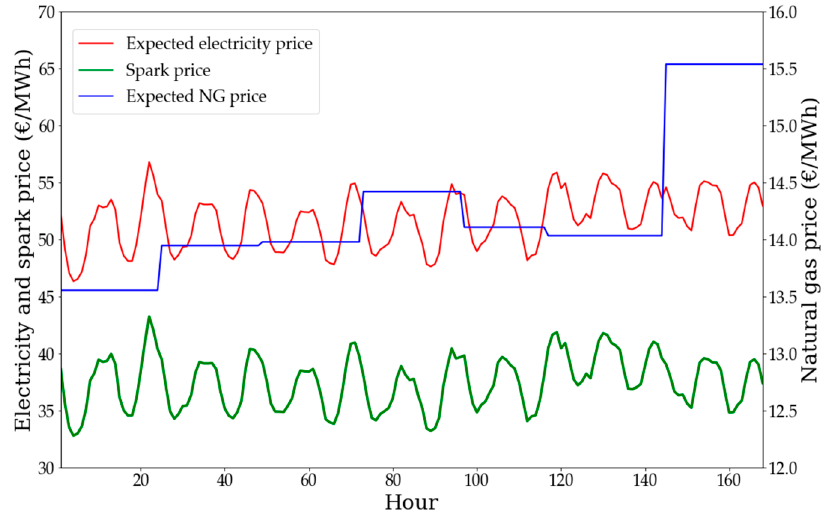
Figure 12. Expected spark price and expected prices of electricity and natural gas.